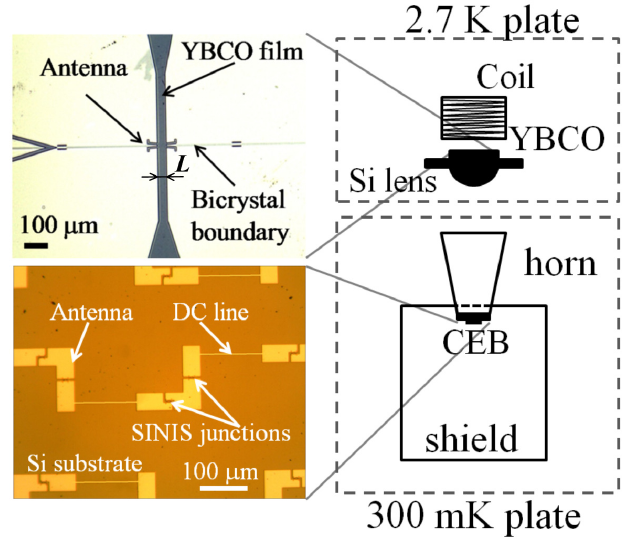
Figure 1. The view of the experimental setup, its schematic representation and samples